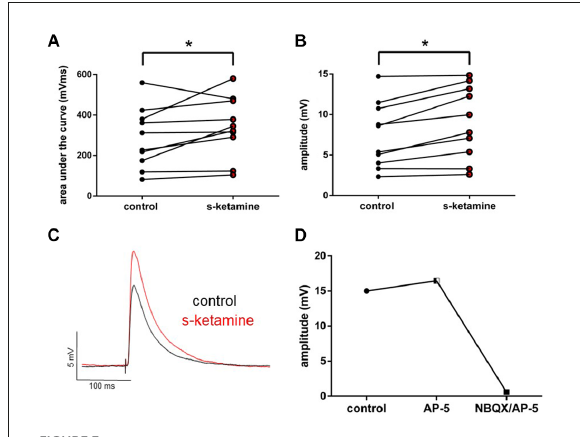
FIGURE3 s-ketamine significantly (*) increased the AUC ( p = 0.037) (A) and the amplitude ( p = 0.004) (B) of intracortical eEPSPs (mixed AMPA-/NMDA-receptor mediated). Cohen’s U3_1 of AUC and the amplitude were each 0.9 (0.7 1). (C) Representative traces. (D) Adding NMDA-receptor antagonist AP-5 and AMPA-receptor antagonist NBQX led to a vanishing of intracortical oEPSPs (mixed AMPA-/NMDA-receptor mediated).